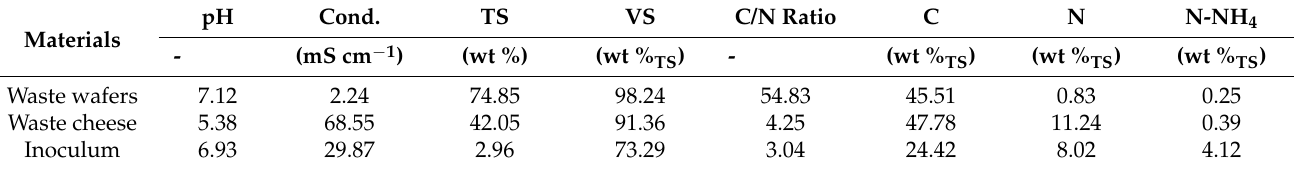
Table 1. Physicochemical properties of substrates and